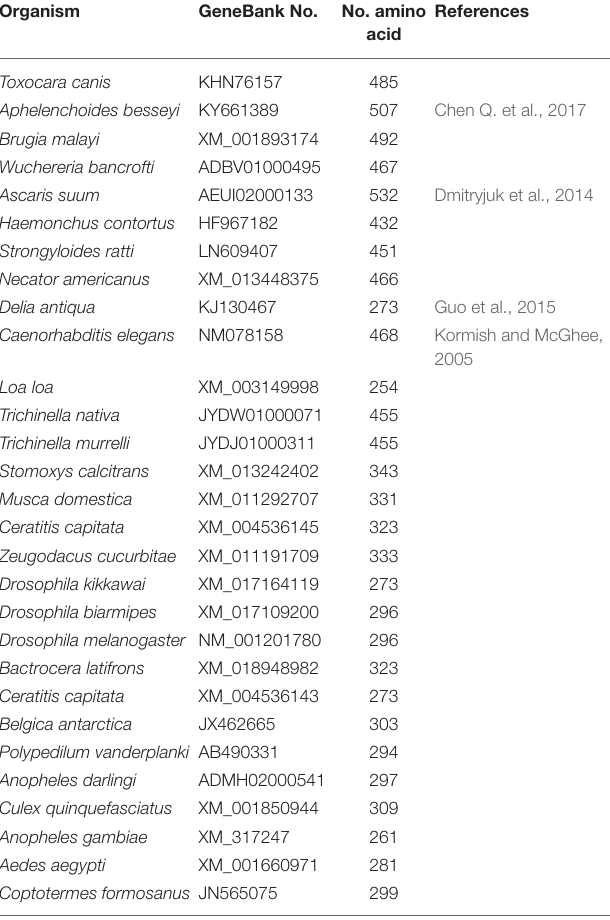
TABLE 2 | Some invertebrate TPP protein sequences from NCBI and published article.